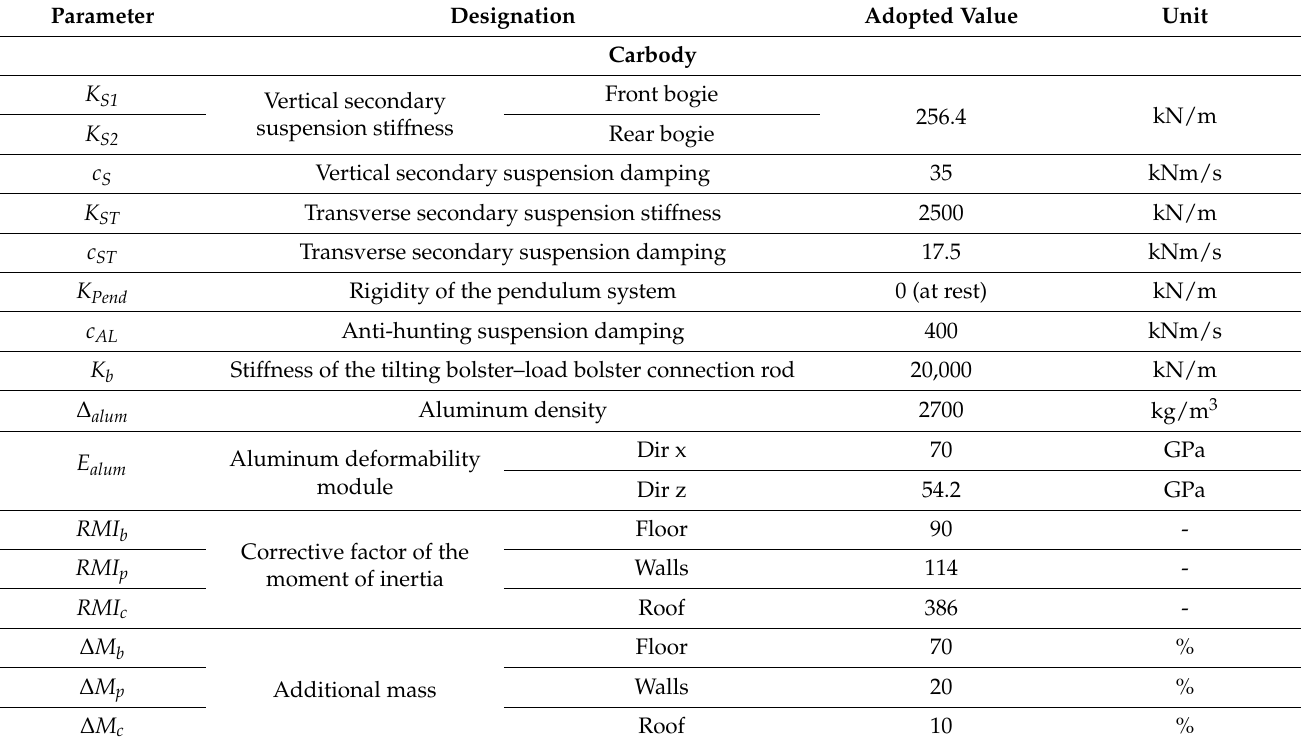
Table 1. Main parameters of the BBN vehicle ’s numerical model.